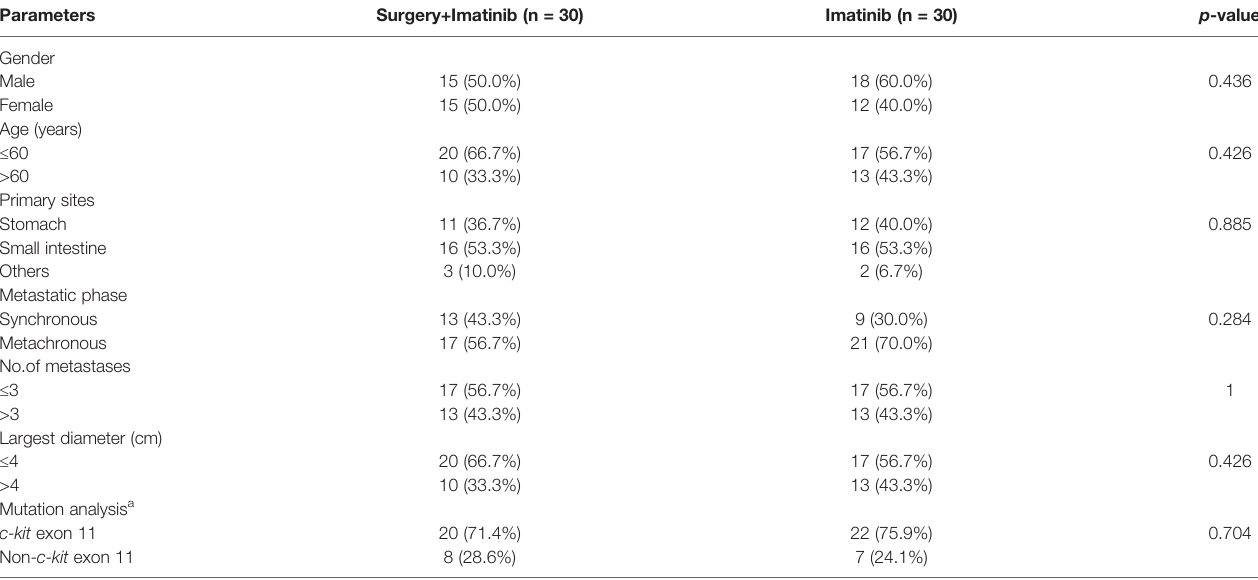
TABLE 3 | Baseline clinical characteristics of patients after propensity score